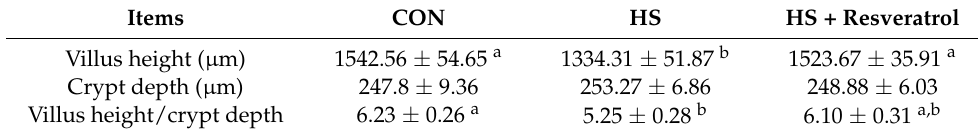
Table 5. Effect of resveratrol on the morphology of jejunum of broilers under HS.